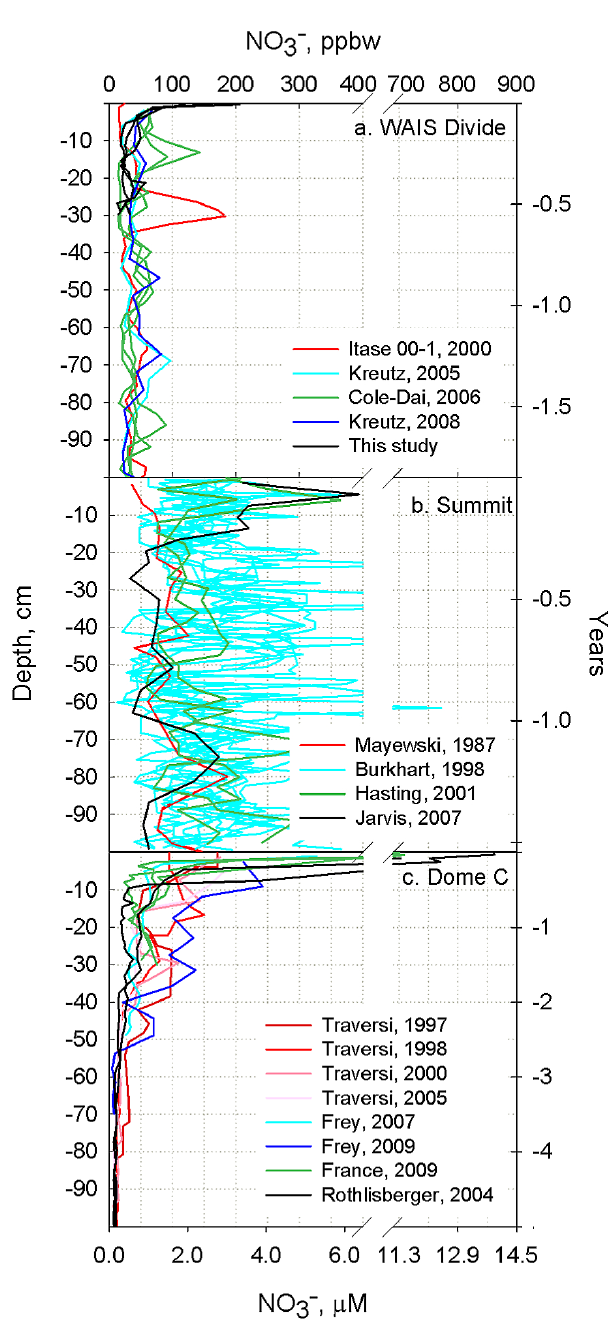
Fig. 8. The 1m NO − profiles from snowpits reported from WAIS 3 Divide, Summit, and Dome C (Frey et al., 2013; France et al., 2011; Traversi et al., 2009; Burkhart et al., 2004; Hastings, 2004; Roth- lisberger et al., 2000; Mayewski et al., 1990, Jarvis (unpublished